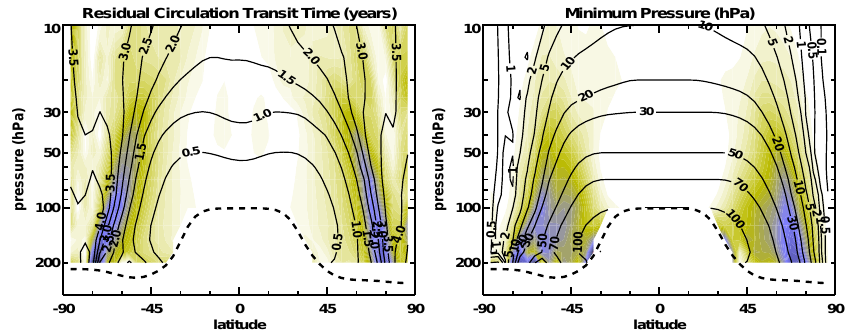
Fig. 3. Black contours: annual mean transit time (left, in years) and minimum pressure visited (right, in hPa) of trajectories along time- dependent annually repeating residual streamlines from CMAM. The background color shading quantifies the absolute value of the merid- ional gradient of the displayed fields (in arbitrary units, darker shading for larger gradients, blue for largest gradients). Thick dashed lines mark average position of the tropopause.